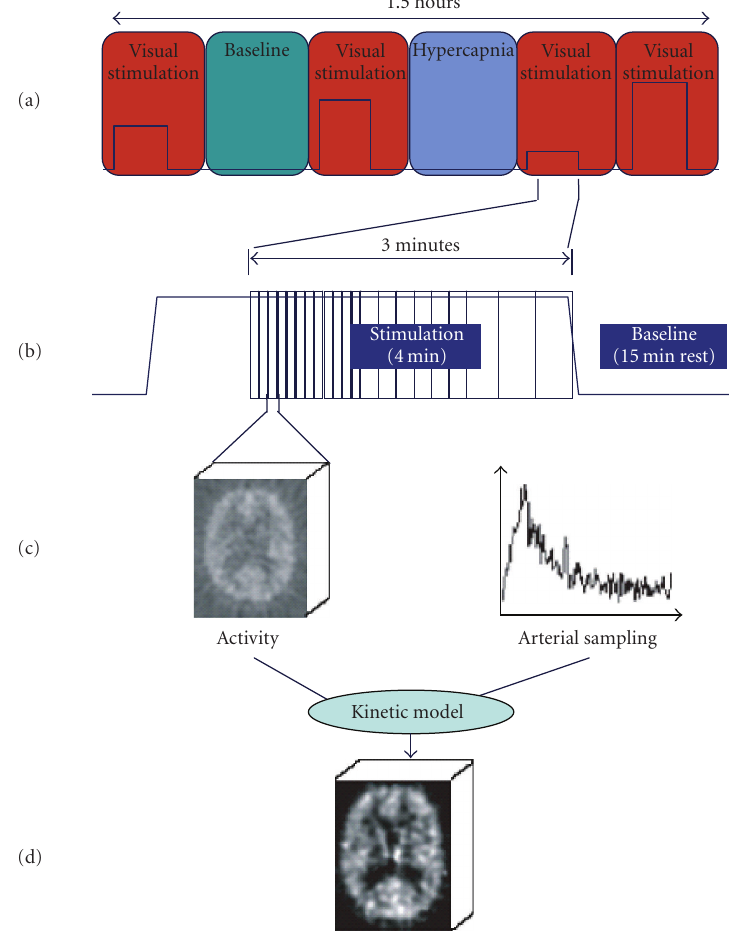
Figure 2: (a) The PET experimental protocol consisted of 6 randomly presented sessions (baseline, hypercapnia, and 4 levels of visual stimulation). A tracer bolus injection was given at the start of each block. (b) Each run has a 3-minute acquisition period divided in 12 5-second, 6 10-second, and 3 20-second frames, followed by 15 minutes of rest. (c) A volume of activity distribution was acquired during each frame. (d) This series of distribution images and the blood activity curve were fit into a kinetic model, resulting in a CBF